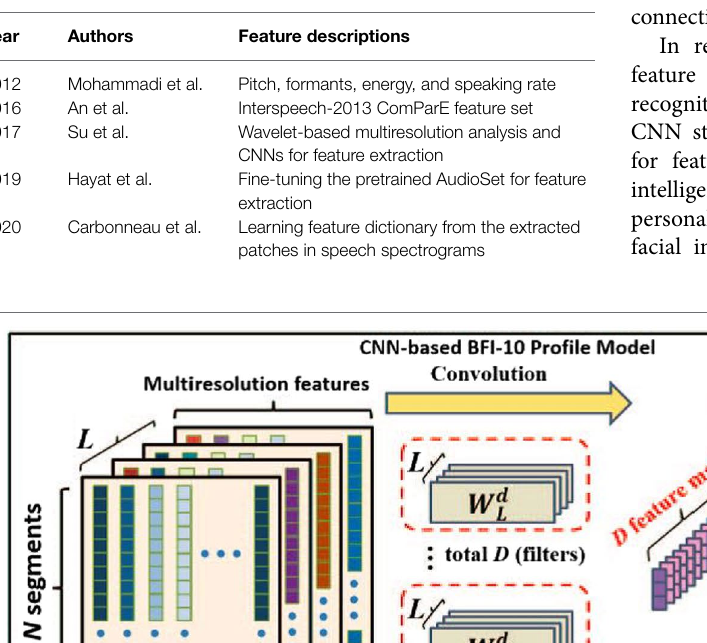
TABLE 3 | A brief summary of audio-based on personality trait recognition.